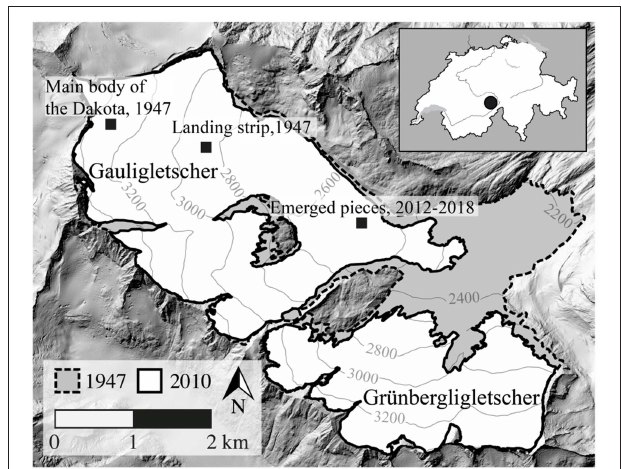
FIGURE 2 | Overview of the topography of Gauligletscher and the former tributary Grünbergligletscher, in 1947 (dashed) and 2010 (continuous), showing the Dakota crash location, the landing strip for the rescue operation and recover expedition, and the location where the emerged pieces were